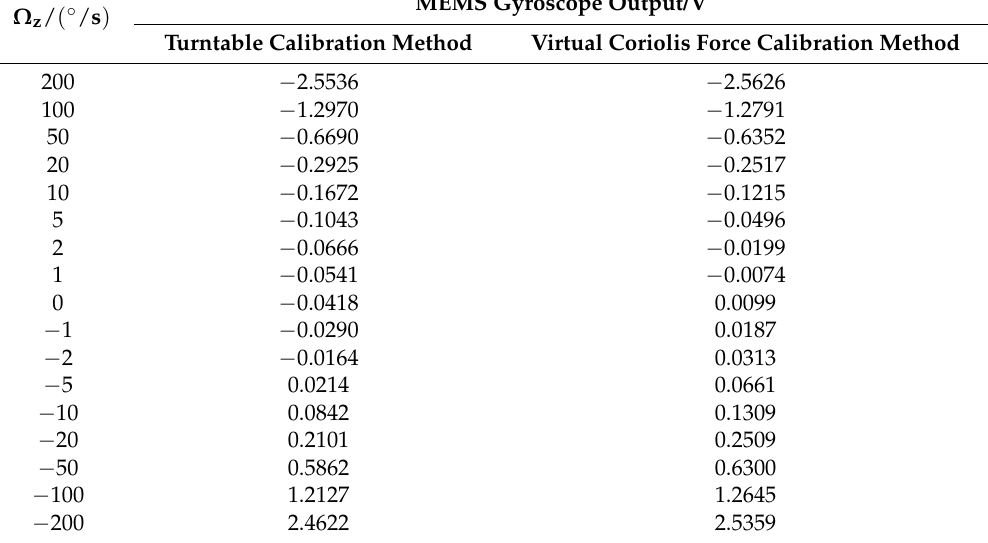
Table 1. Dual-mass microelectromechanical systems (MEMS) gyroscope scale factor calibration experiment at room temperature (20 ◦